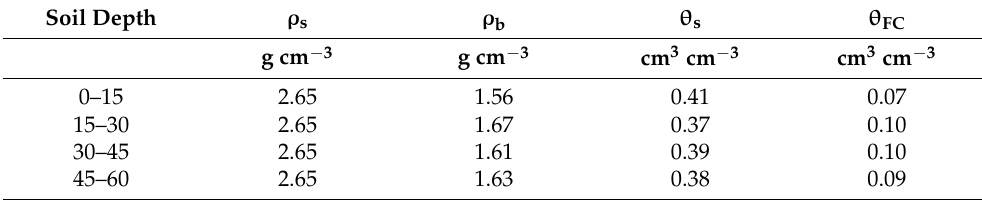
Table 1. Soil bulk density, particle density, volumetric moisture content at saturation and field capacity across four soil depths from the soil